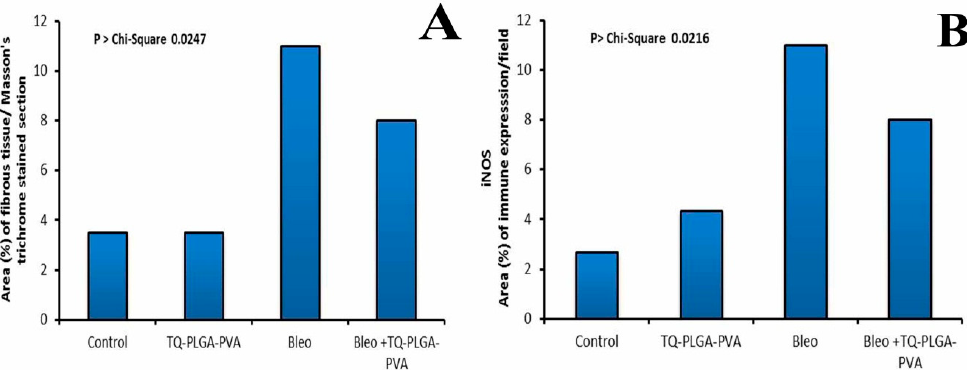
Figure 8. Area percentage of ( A ) Masson’s trichrom stained fibrous tissues, and ( B ) iNOS immune expression in lung tissues from control and treated groups; all scores were subjected to nonparametric analysis using the Kruskal–Wallis test to assess the significance between mean scores obtained from the Wilcoxon rank sum test ( p > Chi-square < 0.0247 for ( A ); p > Chi-square < 0.0216 for ( B )).